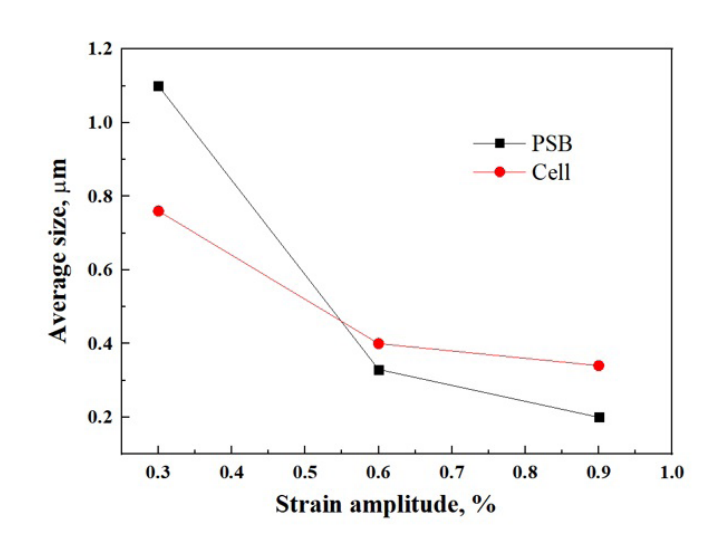
Figure 7. Mean size of PSBs width and cells diameter with the different strain